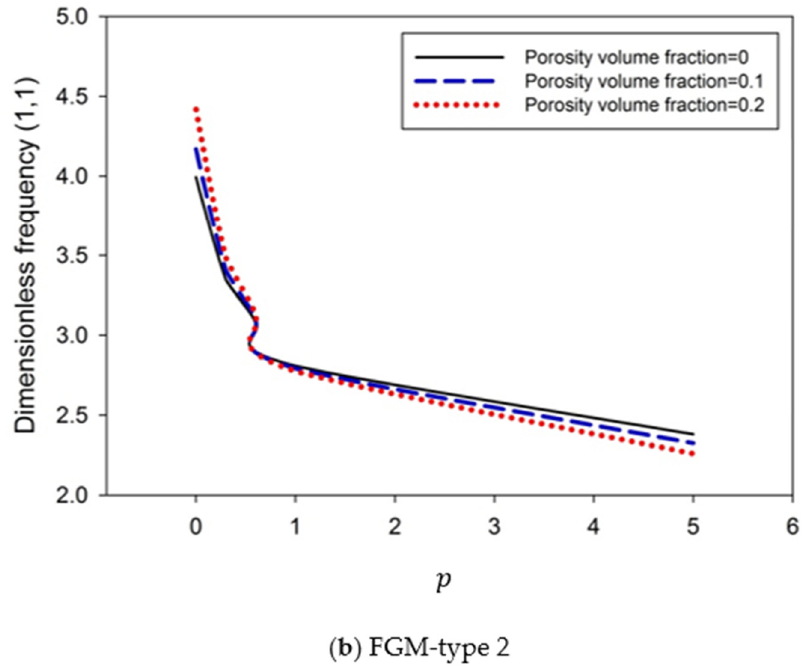
Figure 8. Dimensionless frequency of FG porous hyperbolic paraboloidal shell versus different power-law indices for various porosity volume fractions: ( a ) FGM-type 1; ( b ) FGM-type 2.